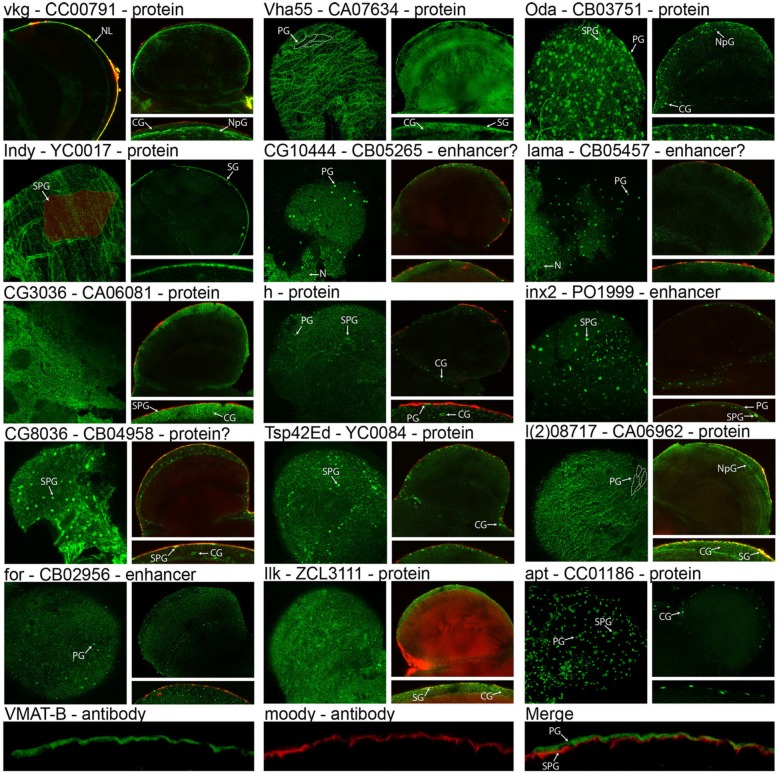
Expression and localization of surface glia-enriched genes. Gene symbols are followed by the FlyTrap database ID number and whether the GFP exon results in a GFP-fusion protein (Protein), likely results in a GFP-fusion protein (Protein?), is controlled by nearby enhancers (Enhancer), or is likely controlled by nearby enhancers (Enhancer?). With the exception of vkg, each FlyTrap line has a surface image followed by a cross section image and a zoomed-in image of the surface glia layer in cross section. For vkg, instead of a surface image, we present a cross-section showing the GFP-positive neural lamella. Localization to the surface glia layer can be assessed using surface images that show membrane GFP at the boundaries of perineurial glia (PG) [see dotted lines in Vha55 and l(2)08717] or subperineurial glia (SPG) (see shaded cell in Indy). In cross section images of membrane GFP, localization to the surface glia can be determined because injection with 70 kDa rhodamine dextran demarcates the PG layer (no dextran was used for Vha55, Oda, apt, and VMAT-B). For nuclear GFP, surface images reveal small PG nuclei and large SPG nuclei. In cross section, these nuclei are within the dextran layer (PG-localized) or slightly below (SPG-localized). Many surface glia-enriched genes are also expressed in other glial subtypes, such as cortex glia (CG) and neuropil glia (NpG), and in rare cases we found that surface glia-enriched genes were also expressed in neurons (N). VMAT-B expression is visualized with polyclonal antibodies (green) and localized by co-staining with antibodies to the SPG-specific Moody protein (red).